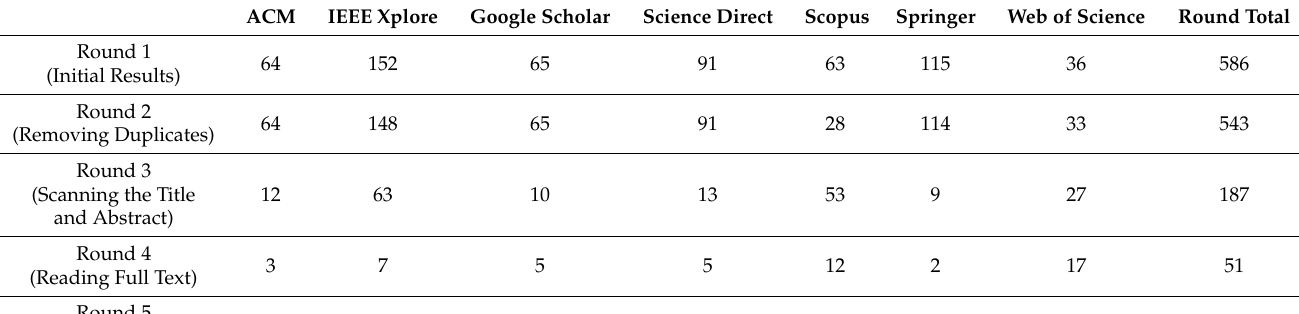
Table 4. Search results of several rounds from the electronic bibliographic